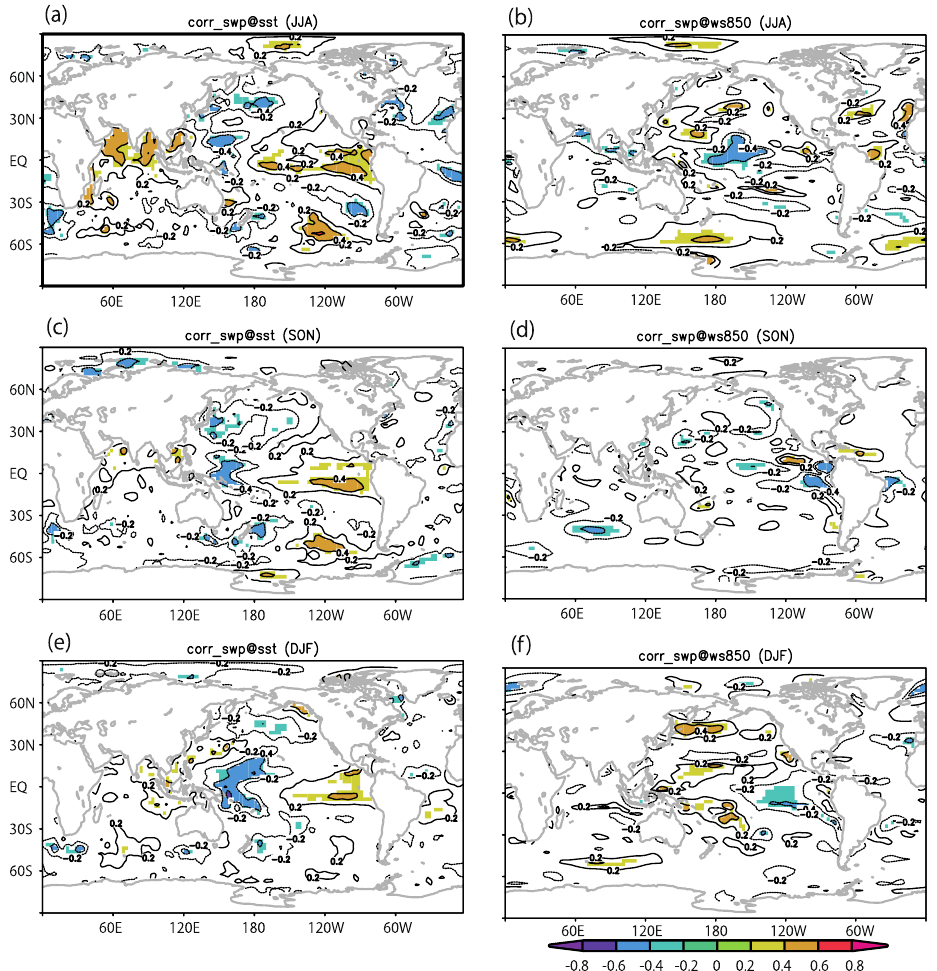
Figure 15. Same as Figure 11 but for wind speed anomaly at 850 hPa (ws850; right panels). ( a ) JJA SST, ( b ) JJA ws850, ( c ) SON SST, ( d ) SON ws850, ( e ) DJF SST, ( f ) DJF ws850.